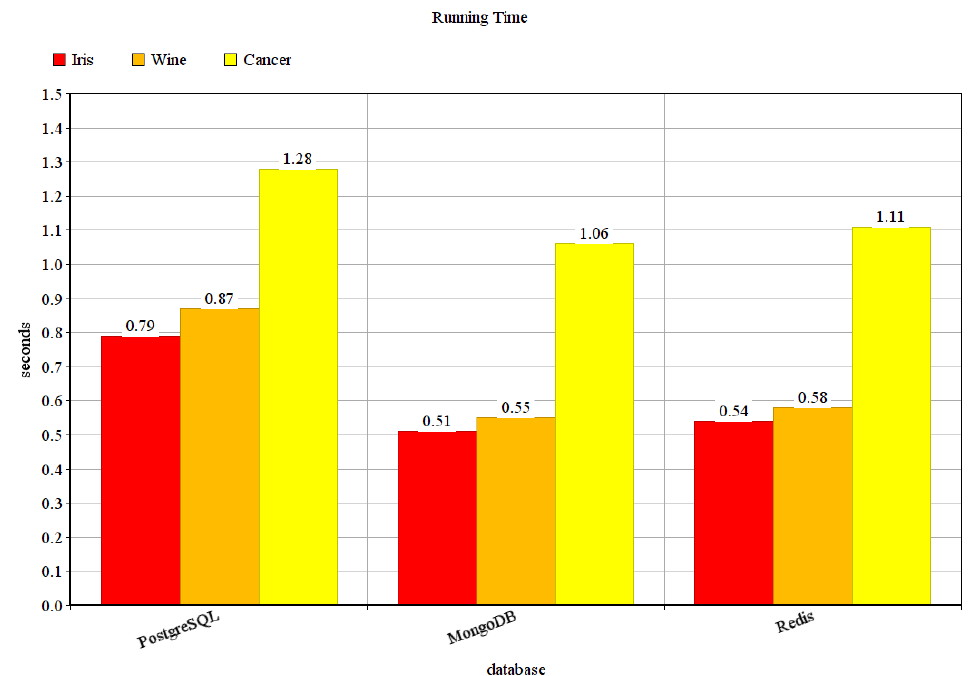
Figure 5. Running time in